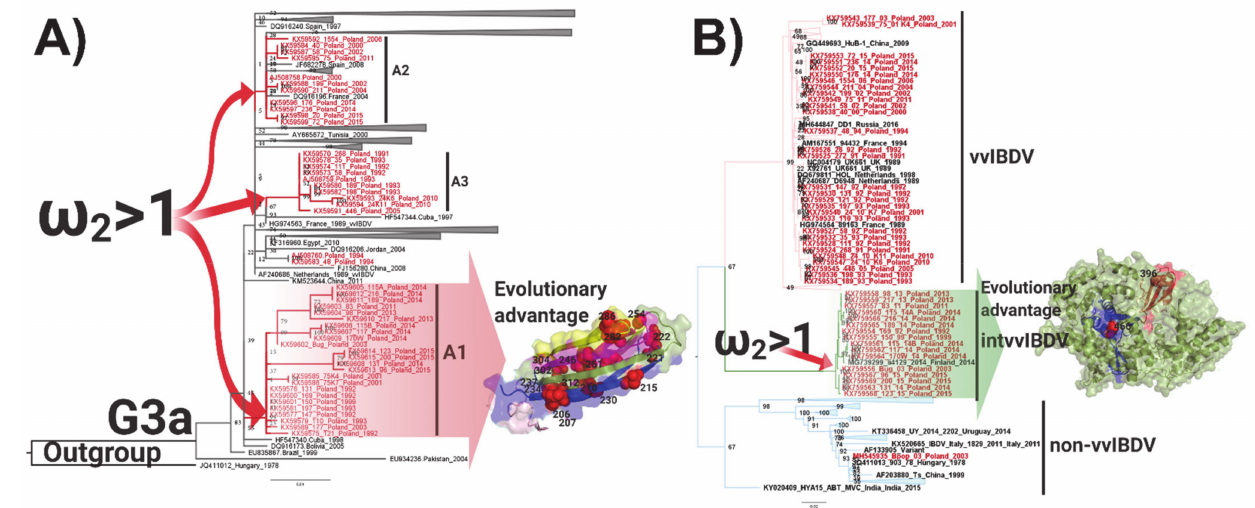
Figure 3. Representation of the topology and identification of positive selected branches and codon sites of Polish IBDV strains. ( A ) Maximum likelihood (ML) phylogenetic tree based on 175 HVR sequences from the G3a genogroup of IBDV clades A1–A3, grouping the Polish VP2 strains, and ( B ) ML phylogenetic tree based on 175 VP1 sequences. In all cases, the clades and lineages that grouped the Polish IBDV strains were analyzed for the branch site model to estimate positive selection using PAML, and the branches that yielded a dN/dS ( ω ) > 1 are denoted. Polish IBDV sequences are denoted in red. Codon sites found in specific lineages under positive selection (see Table S1) were mapped on the structure of the HVR of the crystal representation of the VP2 protein (PDB code: 2df7) and VP1 (PDB code: 2pgg) using Pymol. Clades A1–A3 for the Polish strains based on VP2 analysis and all B-lineages are denoted. Arrows represent positively selected lineages that also contain codon sites positively selected, which represent an evolutionary advantage.